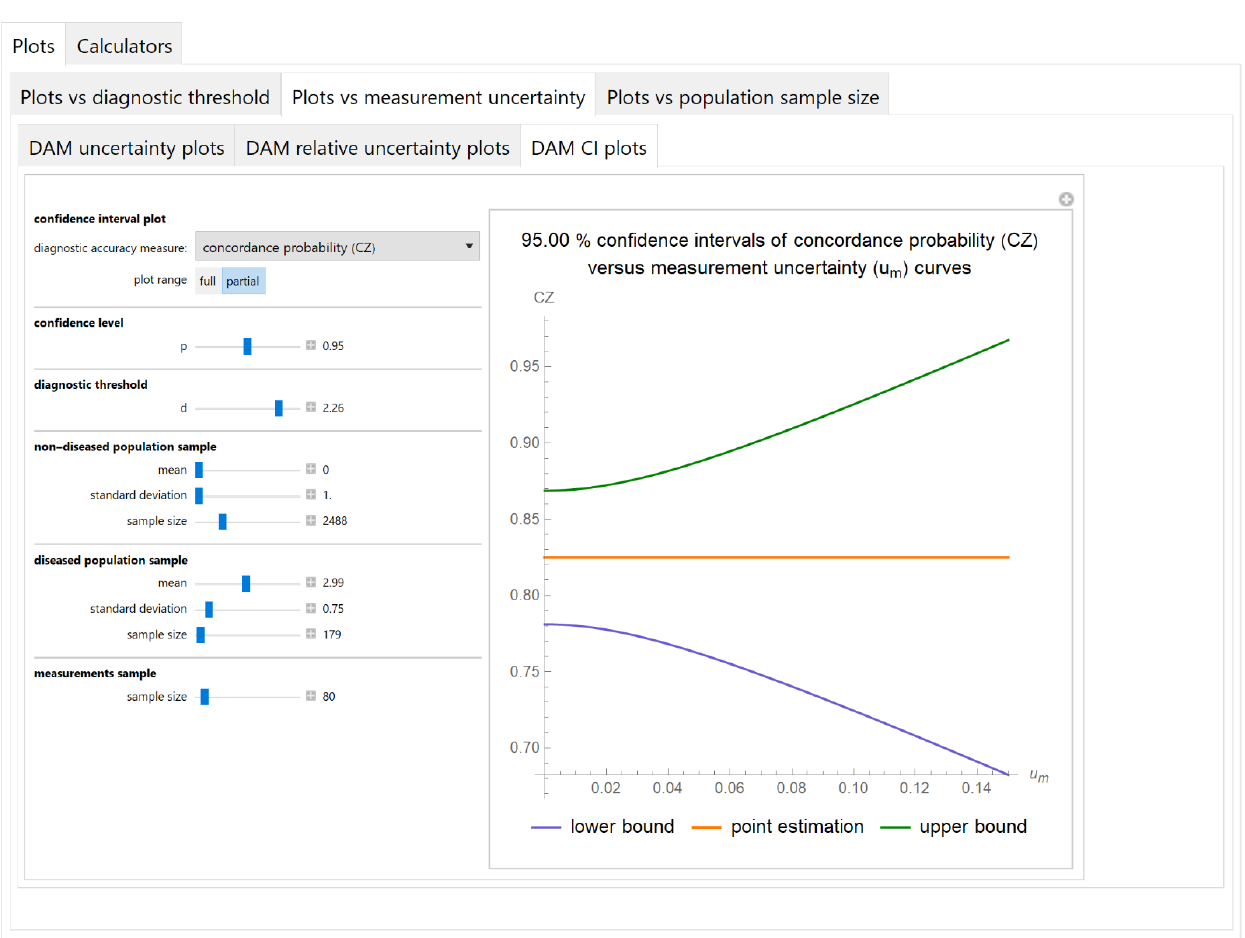
Figure 8. Plots vs. measurement uncertainty module, DAM CI plots submodule screenshot. Confidence intervals of concordance probability ( CZ ) versus standard measurement uncertainty ( u m ) curves plot, with the settings shown on the left. The respective parameter settings are also shown in Table 3.